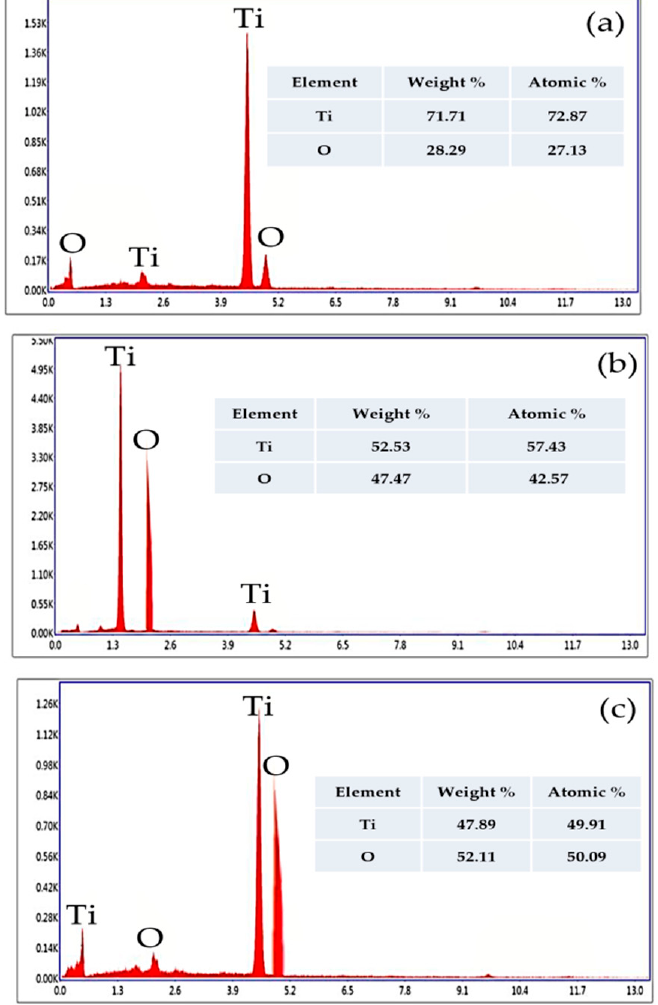
Figure 5. EDS image of titanium nanoparticles formed by: ( a ) Bacillus subtilis , ( b ) Cassia fistula and ( c ) hydrothermal heating showing peaks of titanium and oxygen.